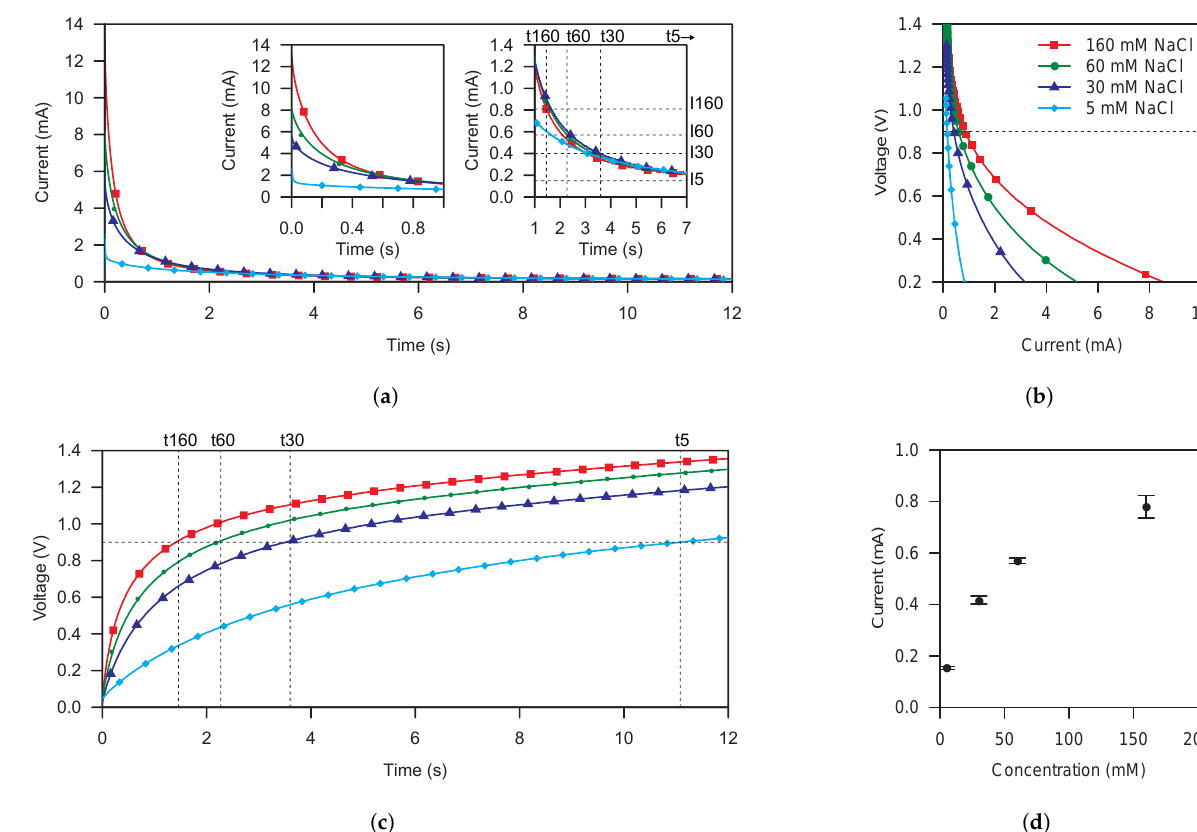
Figure 4. ( a ) Output current transient waveforms of two NaCl-based galvanic cells stacked in series using the 0V to open-circuit potential capacitor-based non-linear sweep voltammetry for samples with an increasing conductivity of 5, 30, 60 and 160m M equiv NaCl. The label pairs ( t 5, I 5), ( t 30, I 30), ( t 60, I 60), and ( t 160, I 160) correspond to the time when a measurement is performed and the corresponding measured current for an increasing conductivity of 5, 30, 60 and 160m M equiv NaCl, respectively. ( b ) Polarization curves of two NaCl-based galvanic cells stacked in series using the 0V to open-circuit potential capacitor-based non-linear sweep voltammetry for samples with an increasing conductivity of 5, 30, 60 and 160m M equiv NaCl. ( c ) Output voltage transient waveforms of two NaCl-based galvanic cells stacked in series using the 0V to open-circuit potential capacitor-based non-linear sweep voltammetry for samples with an increasing conductivity of 5, 30, 60 and 160m M equiv NaCl. The label pairs ( t 5, I 5), ( t 30, I 30), ( t 60, I 60), and ( t 160, I 160) correspond to the time when a measurement is performed and the corresponding measured current for an increasing conductivity of 5, 30, 60 and 160m M equiv NaCl, respectively. ( d ) Current vs. NaCl sample concentration transfer function extracted for a polarization voltage of 0.9V from polarization curves of two NaCl-based galvanic cells stacked in series using the 0V to open-circuit potential capacitor-based non-linear sweep voltammetry for samples with an increasing conductivity of 5, 30, 60 and 160m M equiv